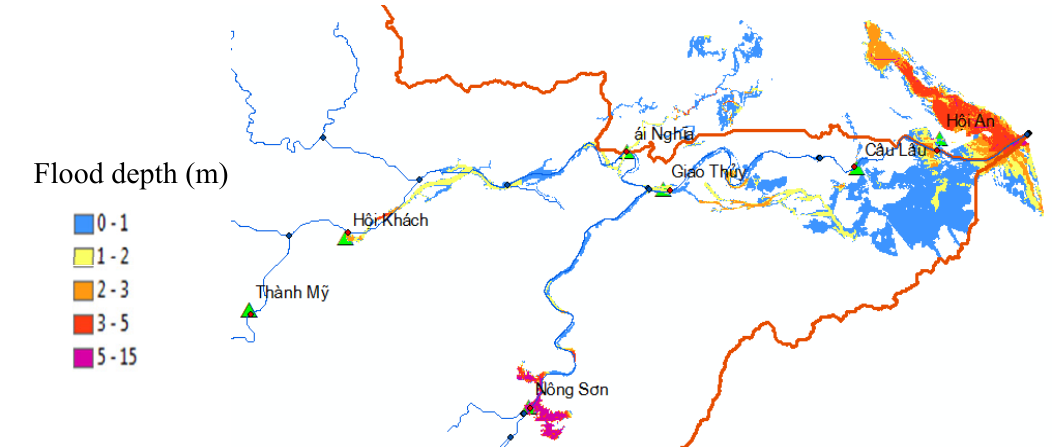
Figure 15. Simulated floodplain map in the lower of the VGTB river basin on November 3, 2016.